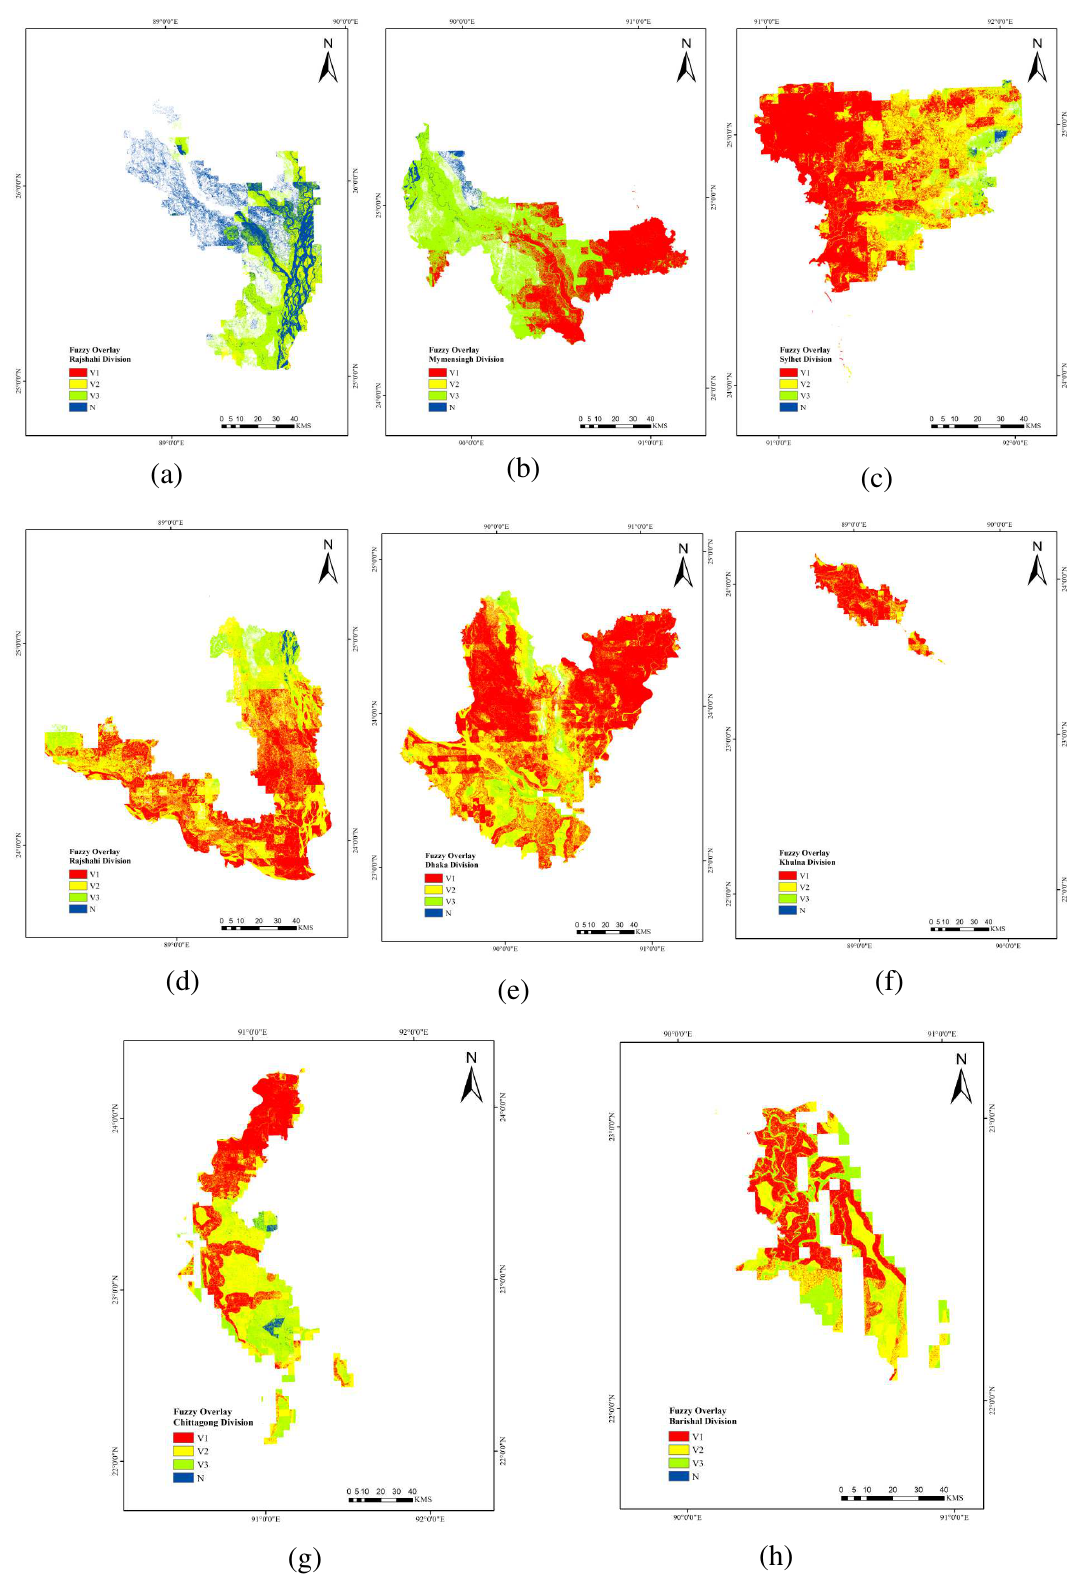
Figure 10. Reclassified fuzzy overlay vulnerability map V1, V2 V3 and N refer to high, moderate, marginal, and nonvulnerable areas, respectively, of different administrative divisions of Bangladesh: ( a ) Rangpur; ( b ) Mymensingh; ( c ) Sylhet; ( d ) Rajshahi; ( e ) Dhaka; ( f ) Khulna; ( g ) Barishal and ( h ) Chittagong.